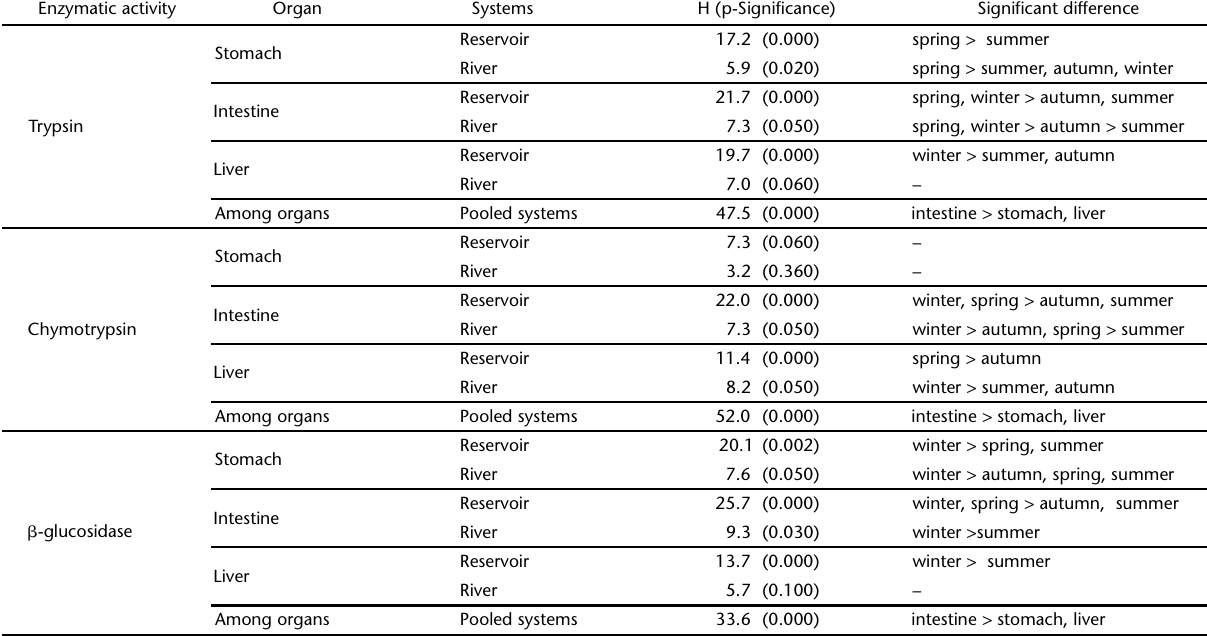
Table II. Significant differences for enzymatic activity of Hypostomus aurogutattus among seasons and organs for each system, according to non-parametric Kruskal-Wallis test. H and P-significance are shown. Enzymatic activity